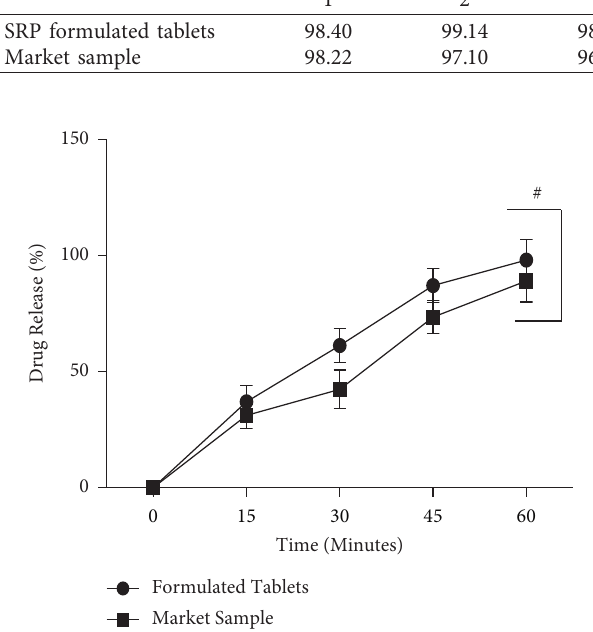
Table 11: The percentage of the residual content of SRP enteric-coated tablets after agitation in simulated gastric fluid (pH 1.2) for 2h. Samples tested Market sample